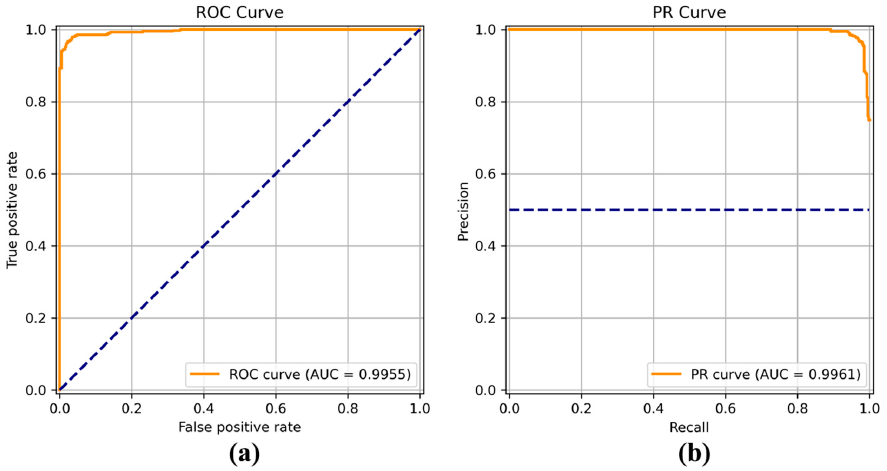
Figure 14. ( a ) Receiver operating characteristic (ROC) curve and ( b ) precision recall (PR) curve of VGG.